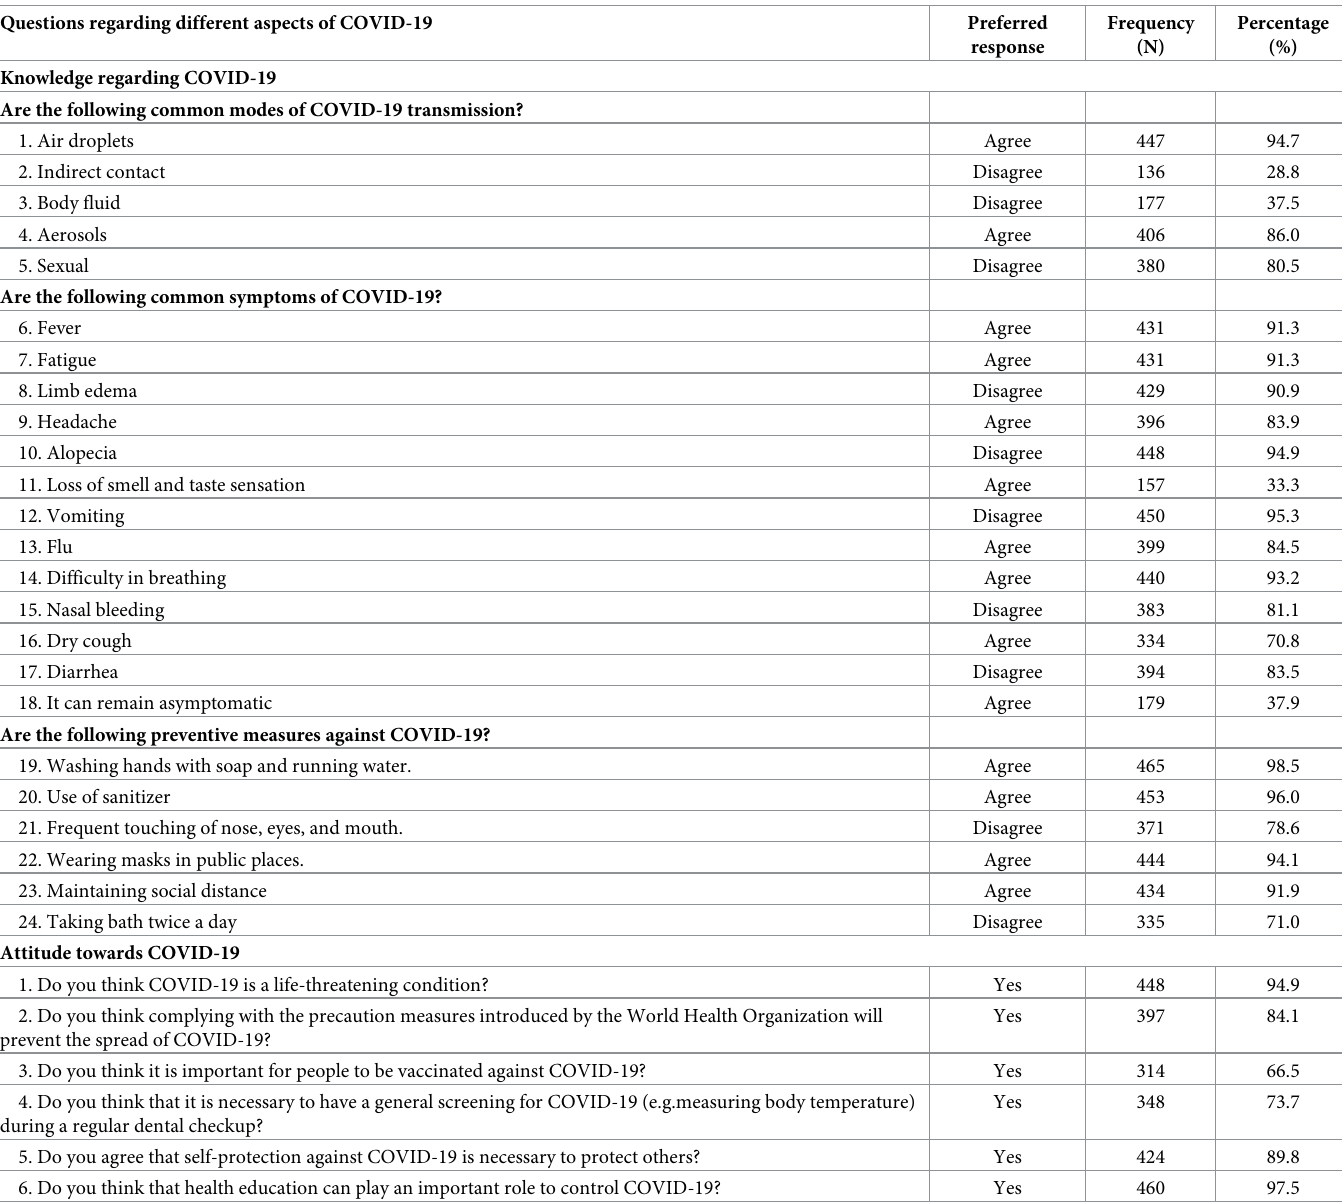
Table 2. Distribution of study participants according to preferred response to the question regarding knowledge and attitude related to COVID-19. Questions regarding different aspects of